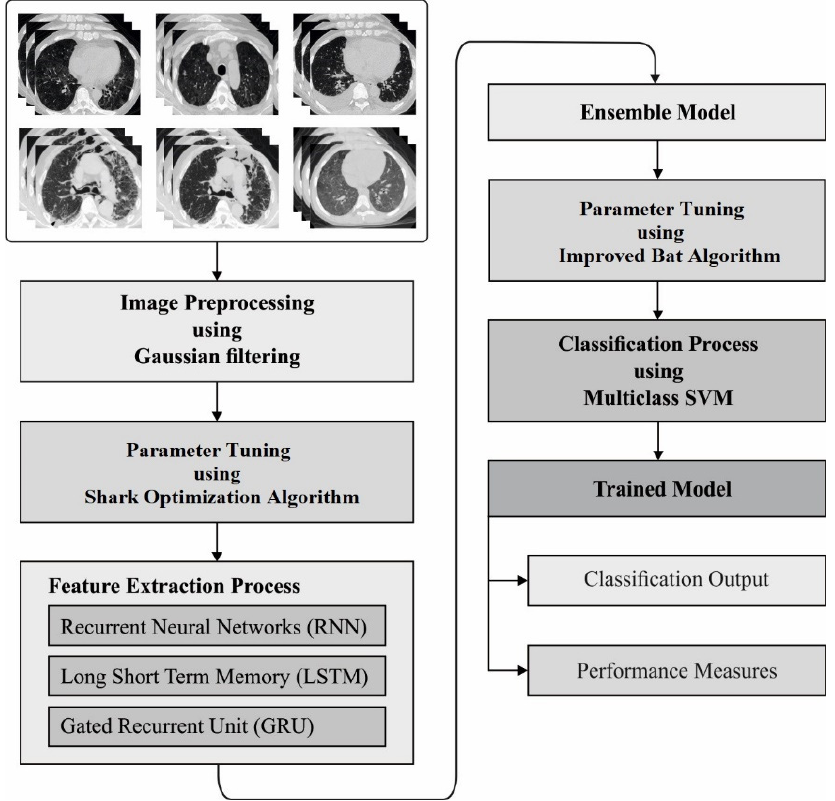
Figure 1. The process flow of proposed model.